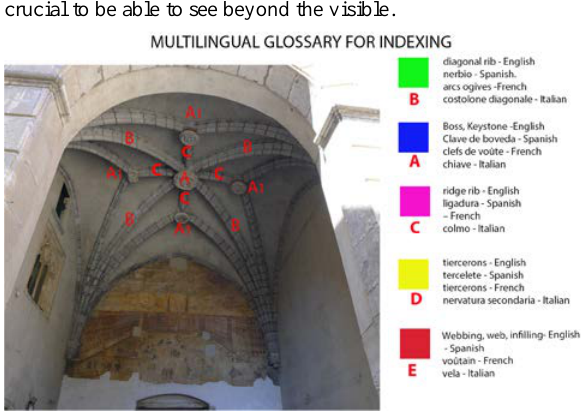
Figure 1 . Terminology used for ribbed vaults components in different languages to improve a multilingual